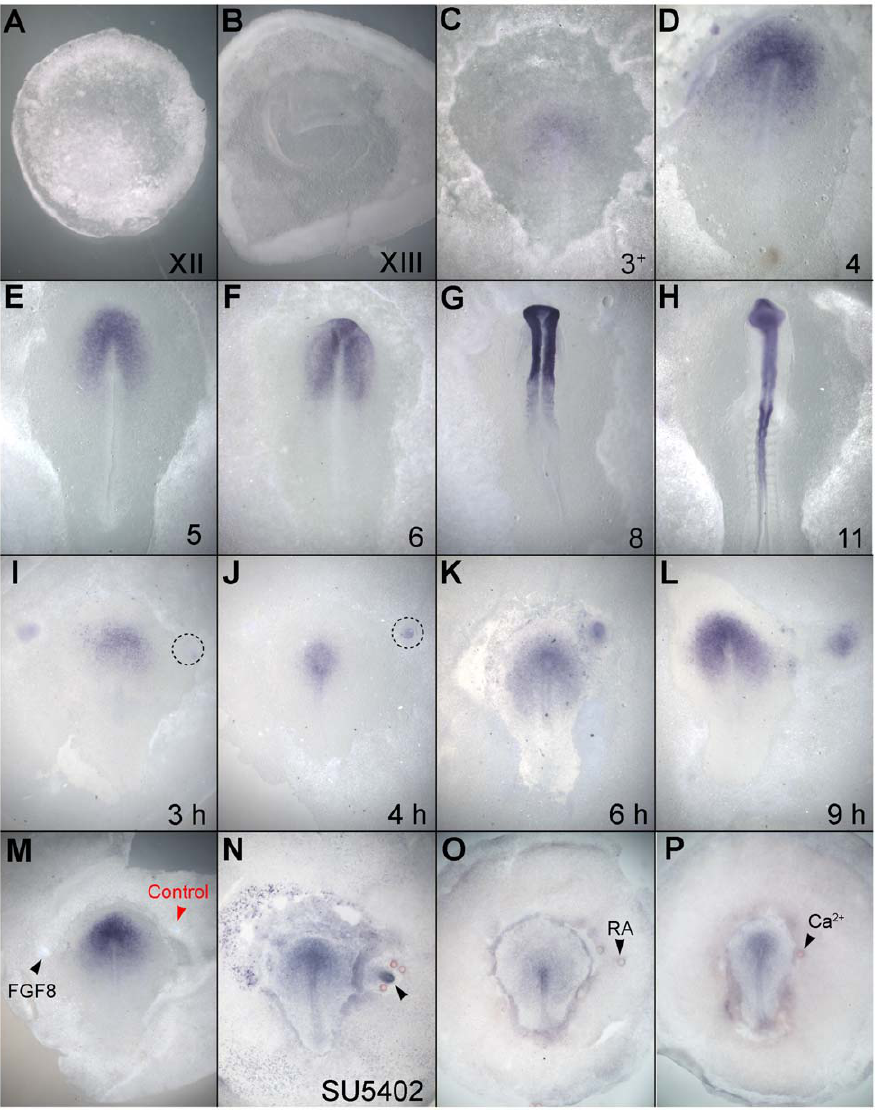
Figure 7. Expression and regulation of TrkC . A–H. TrkC expression during early chick development. The stage of development is indicated on the lower right of each panel. Expression begins at mid-primitive streak stage (stage 3 + ; C) and intensifies in the neural plate thereafter (E–H). I–L. Time-course of induction of TrkC by a graft of Hensen’s node. Induction begins about 4 hours after grafting (J) and becomes strong after about 6 hours (K, L). M. TrkC is not induced by FGF. Embryo shown 6 hours after implantation of a bead soaked in FGF8b (black arrow) and a control bead (red arrow). N. Induction of TrkC by the organizer does not require FGF signals. Embryo shown 6 hours after co-transplantantation of a Hensen’s node and three beads soaked in SU5402. Induction of TrkC is not inhibited (arrow). O. TrkC is not induced by retinoic acid (arrow). P. TrkC is not induced by a bead soaked in ionomycin to increase intracellular Calcium (Ca 2 + ; arrow).